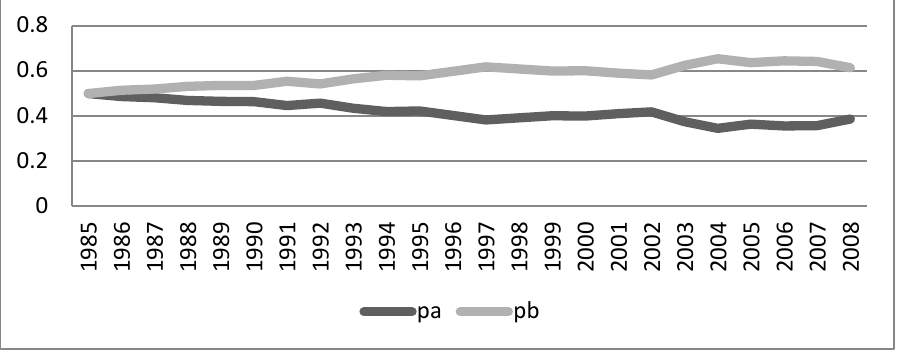
FIGURE 3: Logistics form of the Conflict Success Function from 1985 to 2008, using 1985 as the base year Source: Author’s